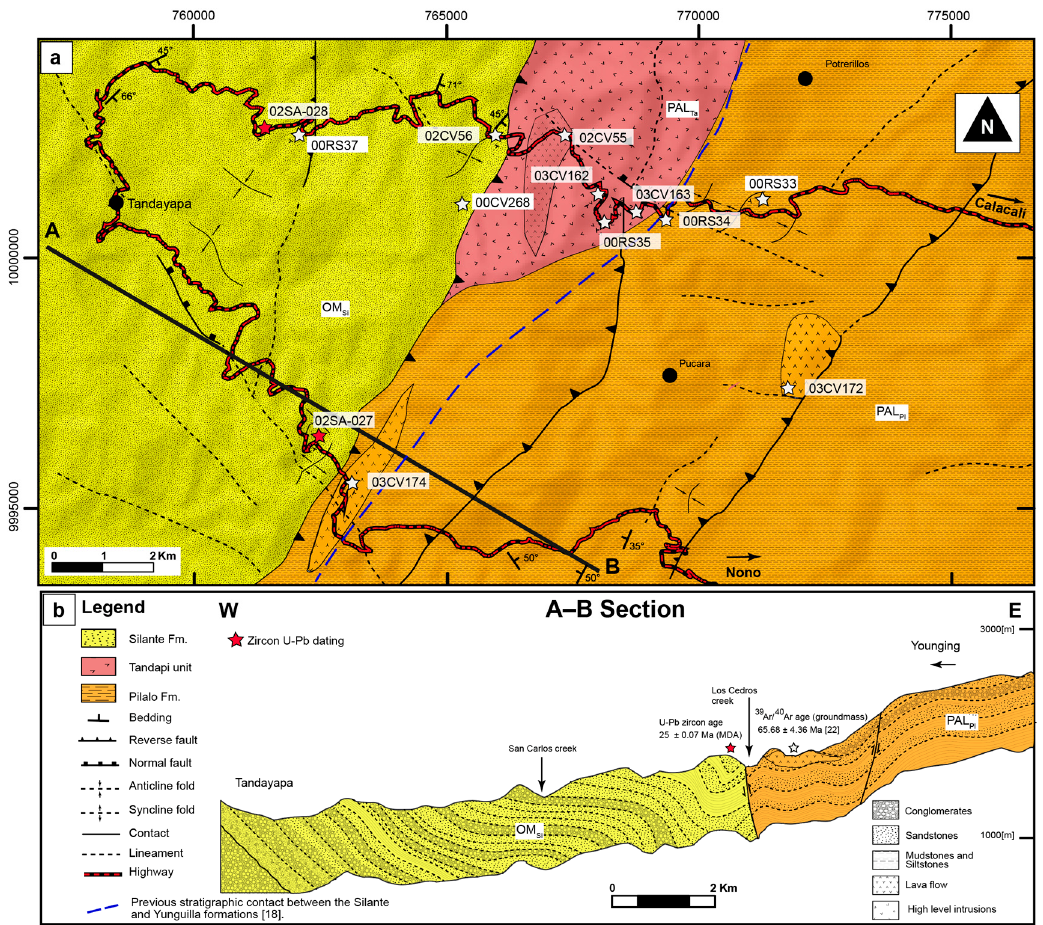
Figure 4. ( a ) Geological map of the area of study, and ( b ) schematic cross sections of the Nono– Figure4. ( a )Geologicalmapoftheareaofstudy, and( b )schematiccrosssectionsoftheNono–Tandayapa Tandayapa road section. road